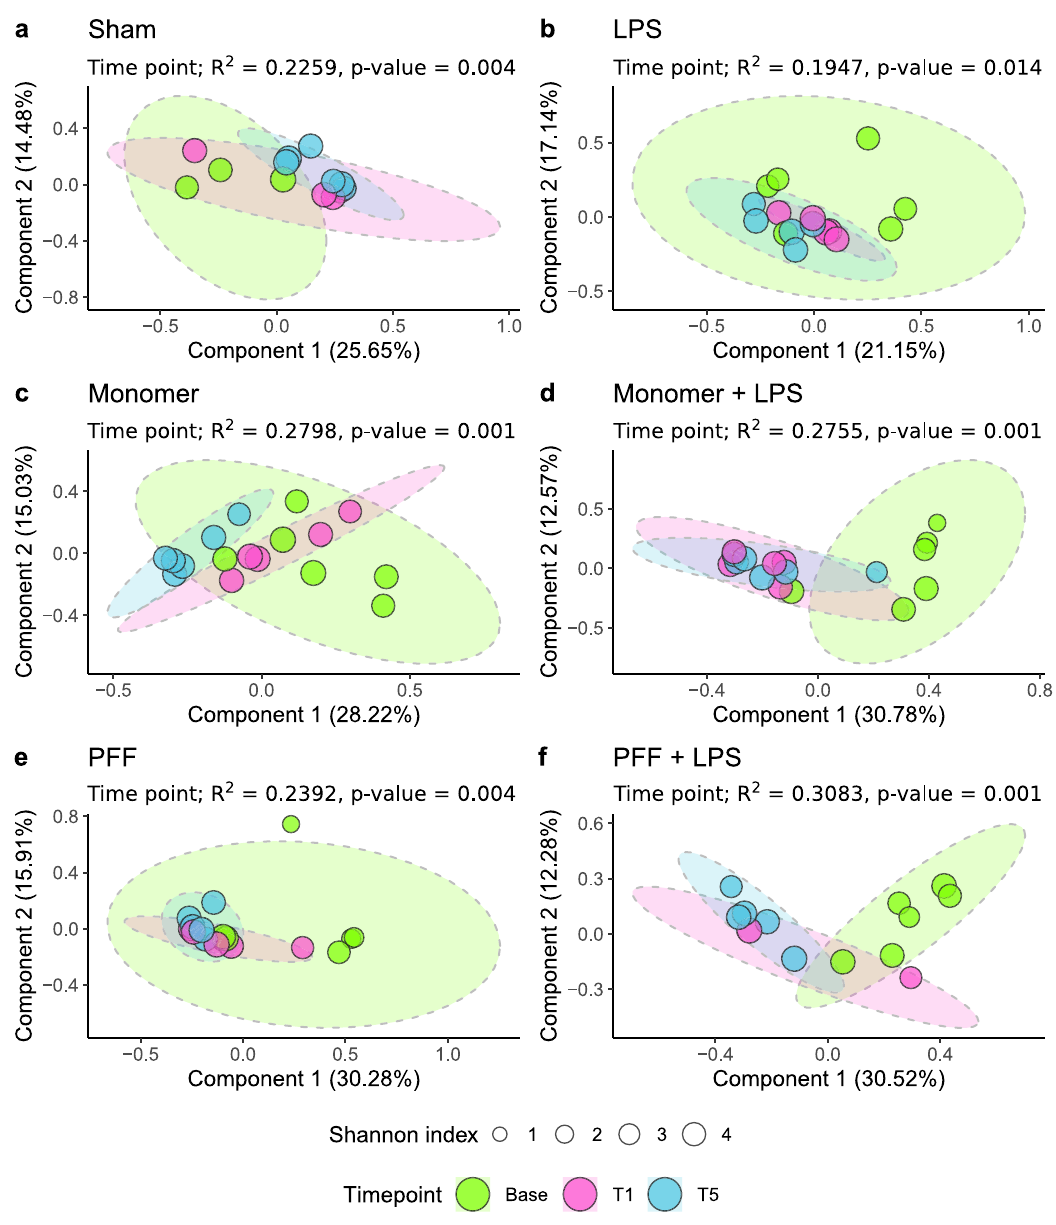
Fig. 3 α - and β -diversity analysis of the rat faecal virome by treatment condition. Ellipses group samples by the study time points investigated. The size of sample points represents their Shannon index α -diversity, while the two-dimensional PCoA ordination of sample points represents their β -diversity dissimilarity using the Bray – Curtis index. The treatment conditions investigated in this study are; a Sham, b LPS, c α -syn monomer, d α -syn monomer plus LPS, e α -syn PFF, and f α -syn PFF plus